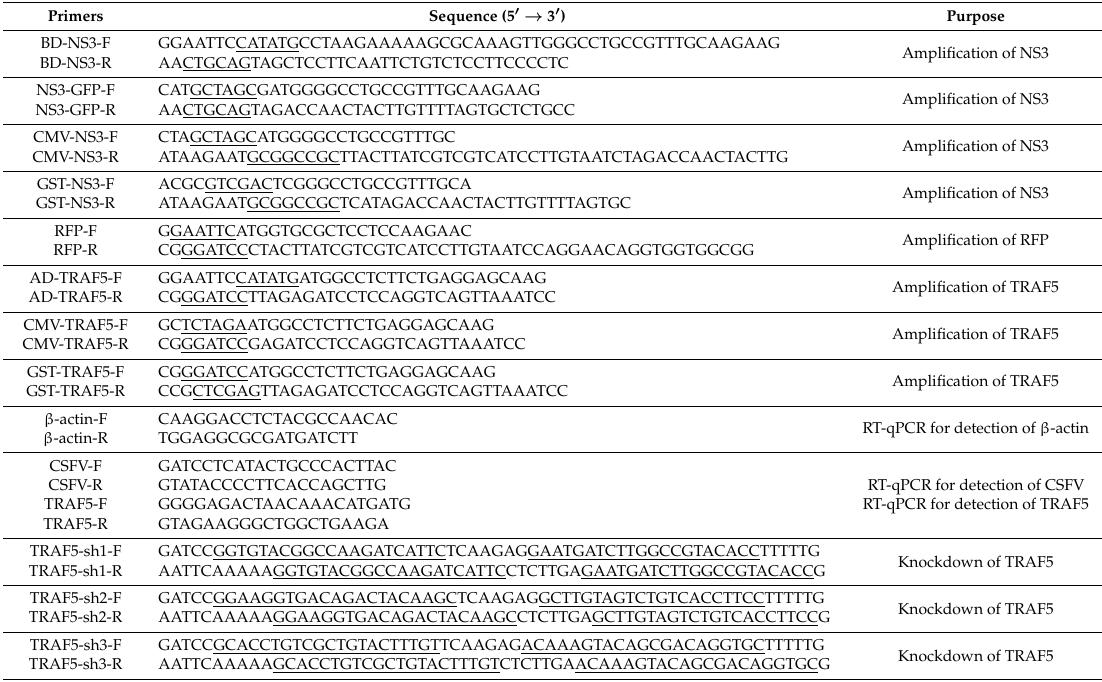
Table 1. Primers used in this